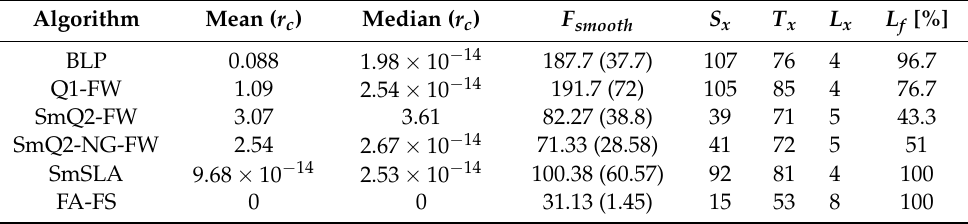
Table 2. Results obtained for the smallest farm with 16 ports, 16 EVs, and random charging rates. The maximal number of EVs that can be charged in one time slot is restricted to five owing to the power limit.